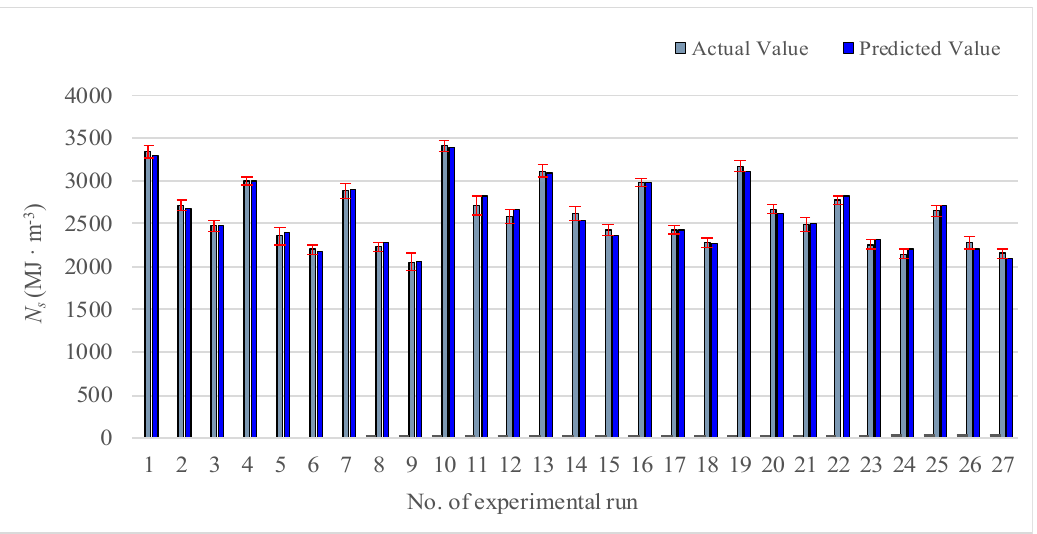
Figure 5. Comparison chart between predicted value and measured value (N s ).